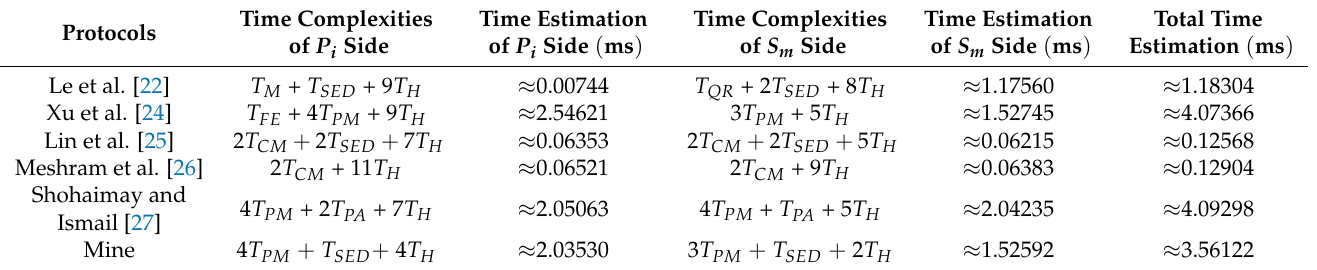
Table 5. Comparison of computation cost.